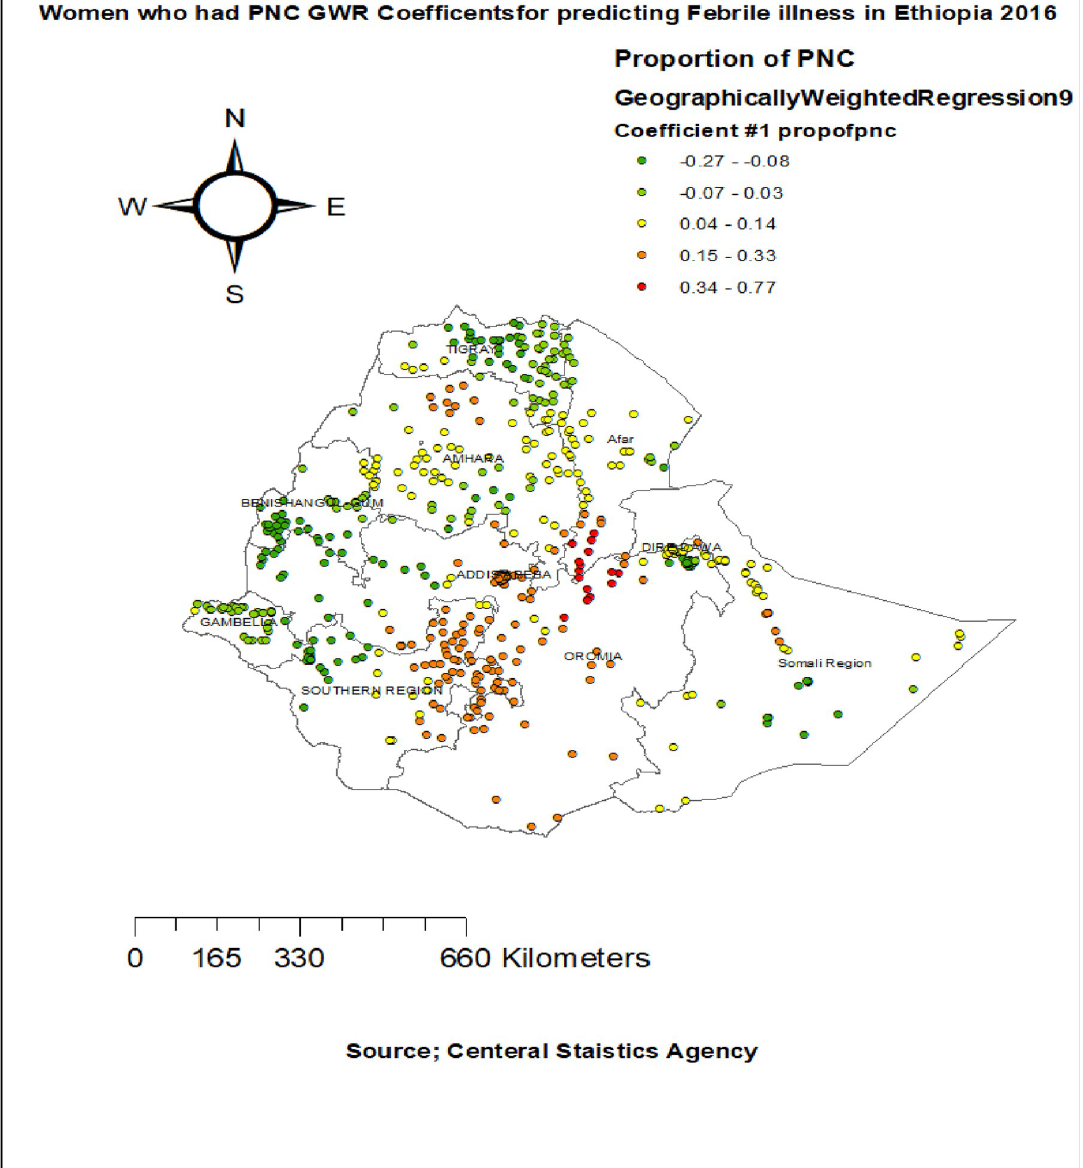
Fig 6. Women who had PNC months GWR coefficients for predicting febrile illness among under five children in Ethiopia, 2016.